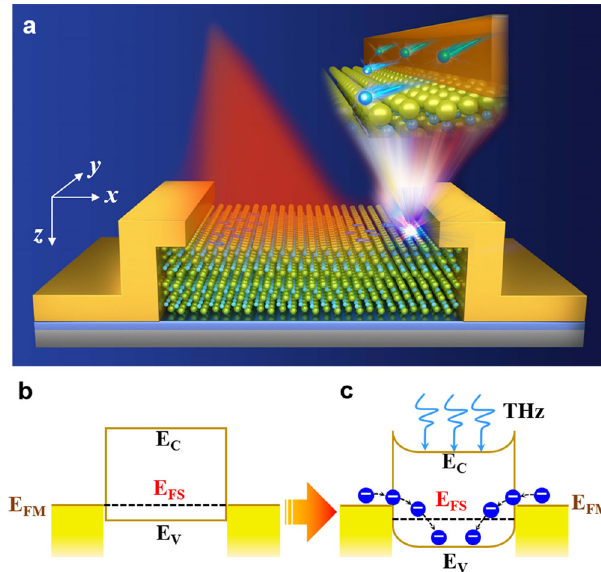
Fig. 3 EIW detection mechanism. a Three-dimensional rendering of the operation principle of the photodetector in the THz band. b , c Show the band structure of Sb 2 Te 3 with MSM structure before and after THz